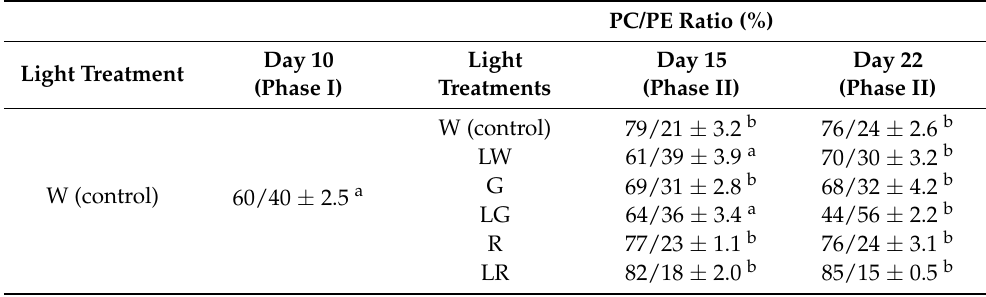
Table 3. Phycocyanin/phycoerythrin (PC/PE) ratio on 10th (phase I), 15th and 22nd days (phase II) of cultivation of S. salina LEGE 06155, for the light treatments: W (white, 150 µ mol photons .m − 2 .s − 1 ) (control), LW (low white, 50 µ mol photons · m − 2 . · s − 1 ), G (green, 150 µ mol photons · m − 2 · s − 1 ), LW (low green, 50 µ mol photons · m − 2 · s − 1 ), R (red, 150 µ mol photons · m − 2 · s − 1 ), and LR (low red, 50 µ mol photons · m − 2 · s − 1 ). The results are reported as average ± SD (n = 3) and expressed as %.